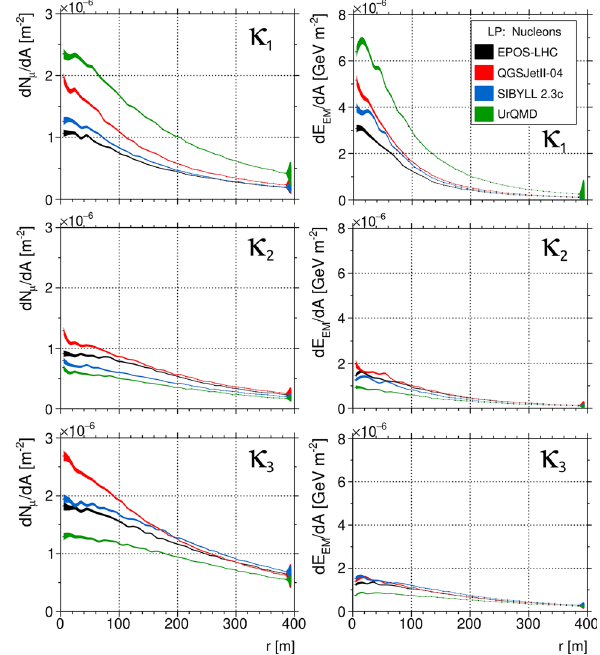
Fig. 2 Breakdown of the muon (left panels) and EM component (right panels) LDFs into the contributions from the three inelasticity regimes in nucleon led events. To have leading particles with similar properties, here energy ranges are taken as a proxy for the respective κ -regions, the boundaries of which are smeared due to event-by-event fluctuations in the energy violation of the